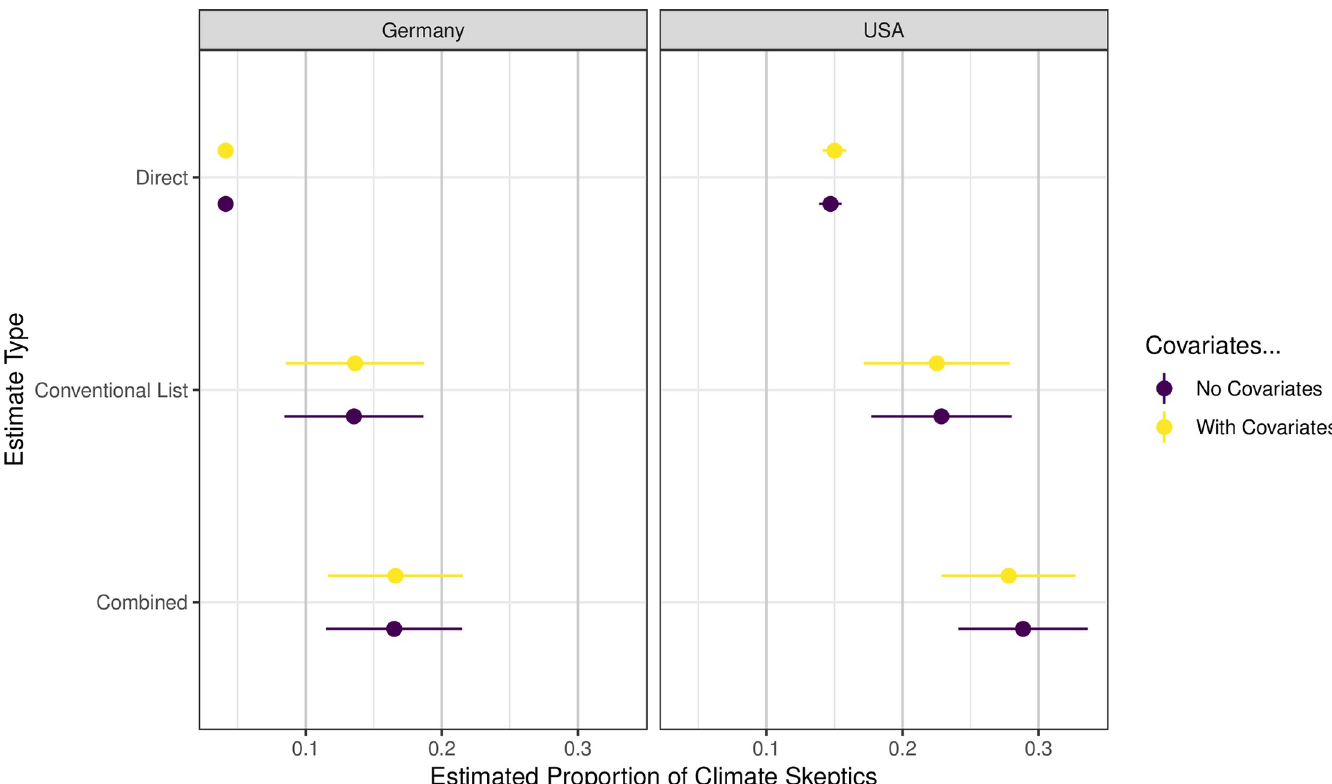
Fig 1. Misreporting of skepticism in human-caused climate change. Each point indicates the estimated proportion of individuals within our sample who believe climate change is in no way caused by humans. The direct questioning and list experiment estimates are displayed, as well as the combined estimate developed by [22]. Lines indicate the 83.4% confidence intervals as an 83.4% interval testing for the overlap of two confidence intervals approximates a 95% interval testing for the exclusion of a single value [26]. These estimates are from models that either simply compare across the different questioning approaches (unadjusted) or also account for personal characteristics of individuals